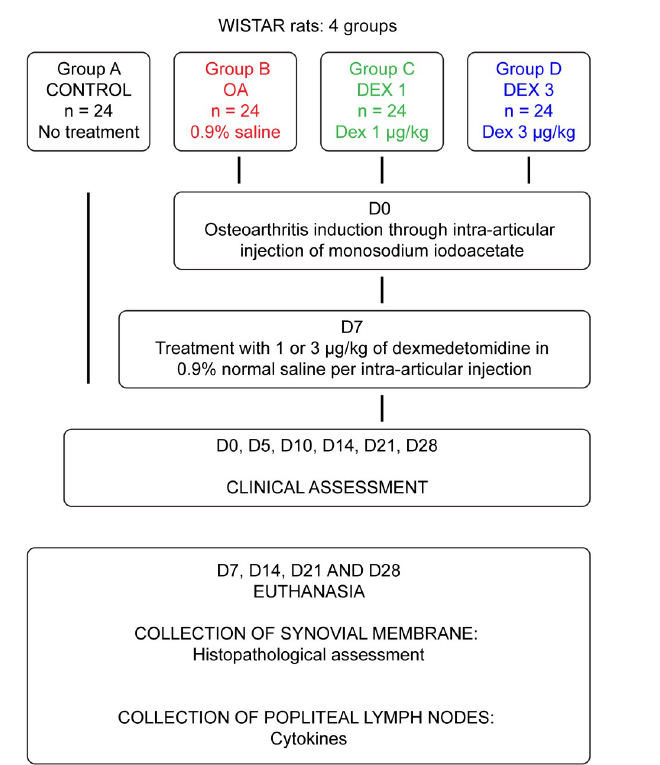
Fig 1. Flowchart representing the experimental